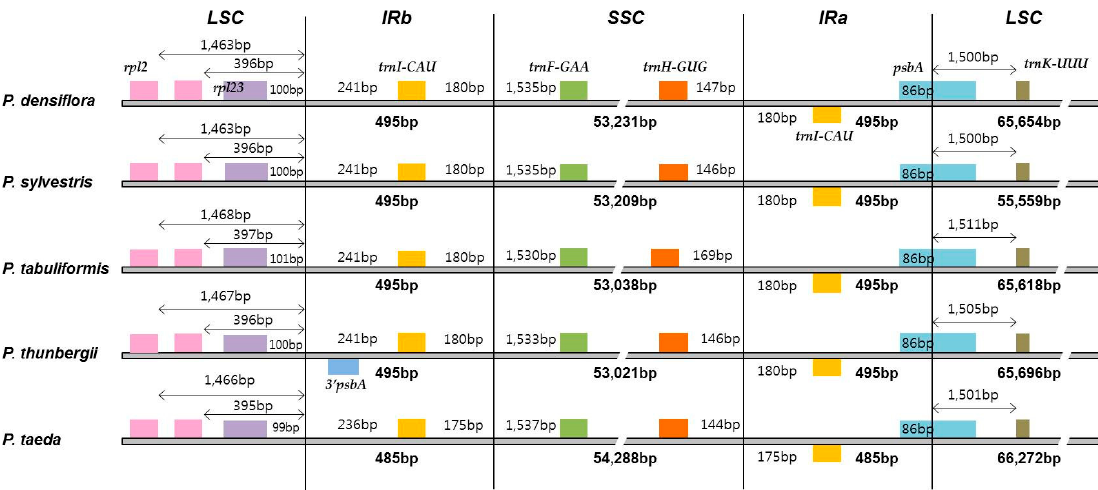
Figure 3. Distance between adjacent genes and junctions of the small single copy (SSC), large single copy (LSC) and two inverted repeats (IRs) among plastid genomes from five Pinus